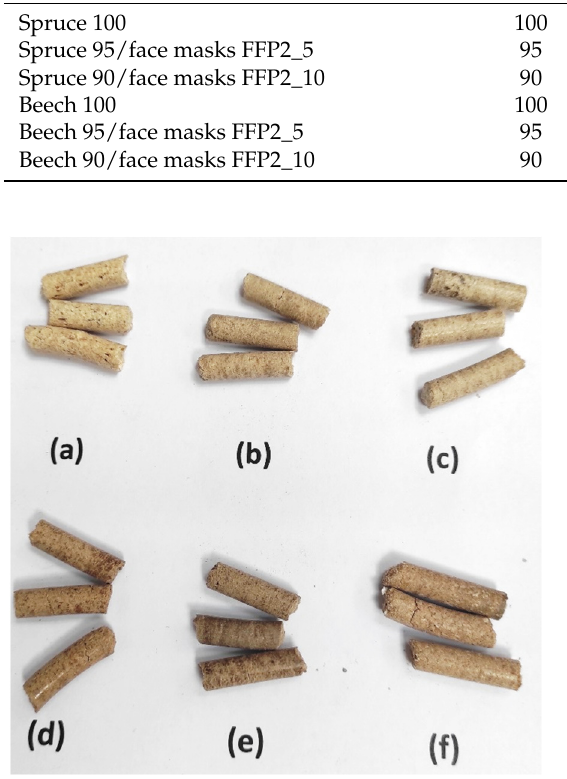
Figure 1. The samples of produced pellets: ( a ) Spruce 100; ( b ) Spruce 95/face masks FFP2_5; ( c ) Spruce 90/face masks FFP2_10; ( d ) Beech 100; ( e ) Beech 95/face masks FFP2_5; ( f ) Beech 90/face masks FFP2_10.